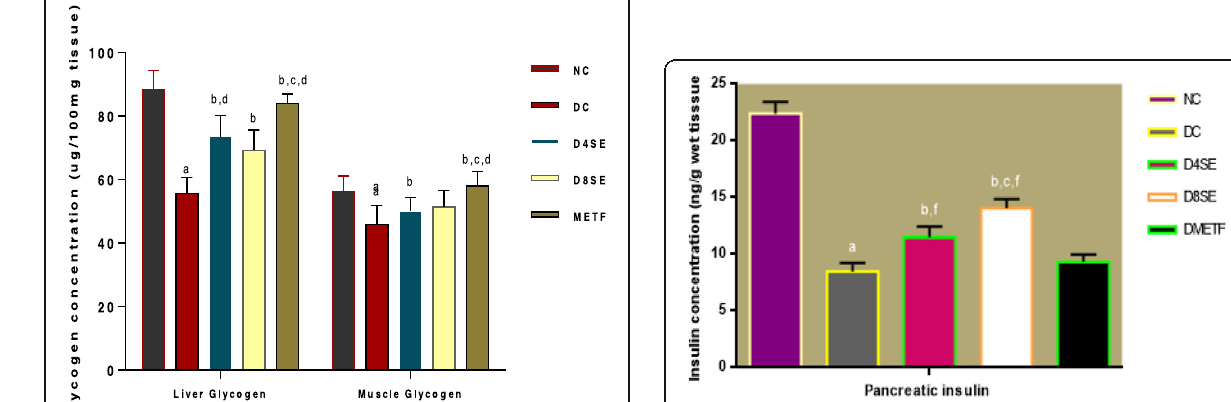
Effects of SE extract on the histological architecture of the pancreas The photomicrographs of thin sections of pancreas excised from normal, untreated diabetic and treated dia- betic rats are shown in Fig . 7.